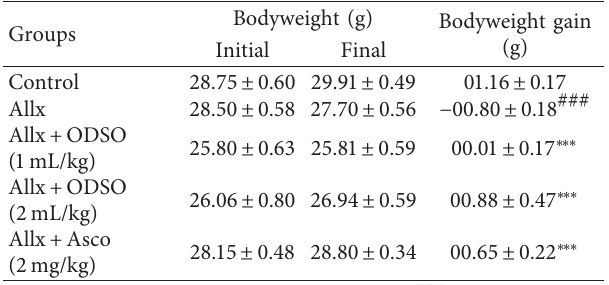
Table 1: Changes in the body weight before and after Allx in- traperitoneal administration in the ODSO and the ascorbic acid- treated mice